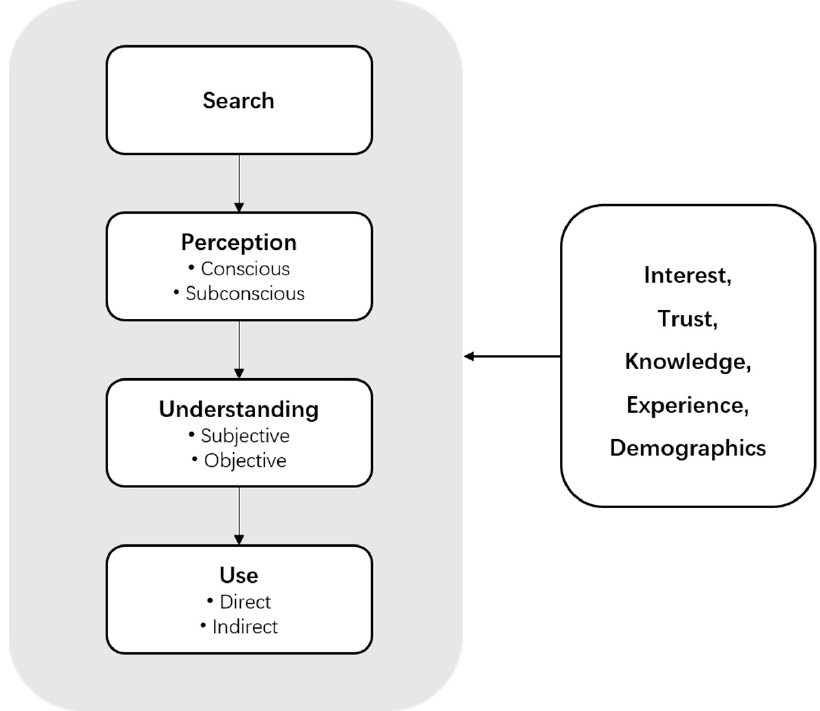
Figure 2. Consumer information processing model (adapted from Grunert and Wills (2007) [37]).